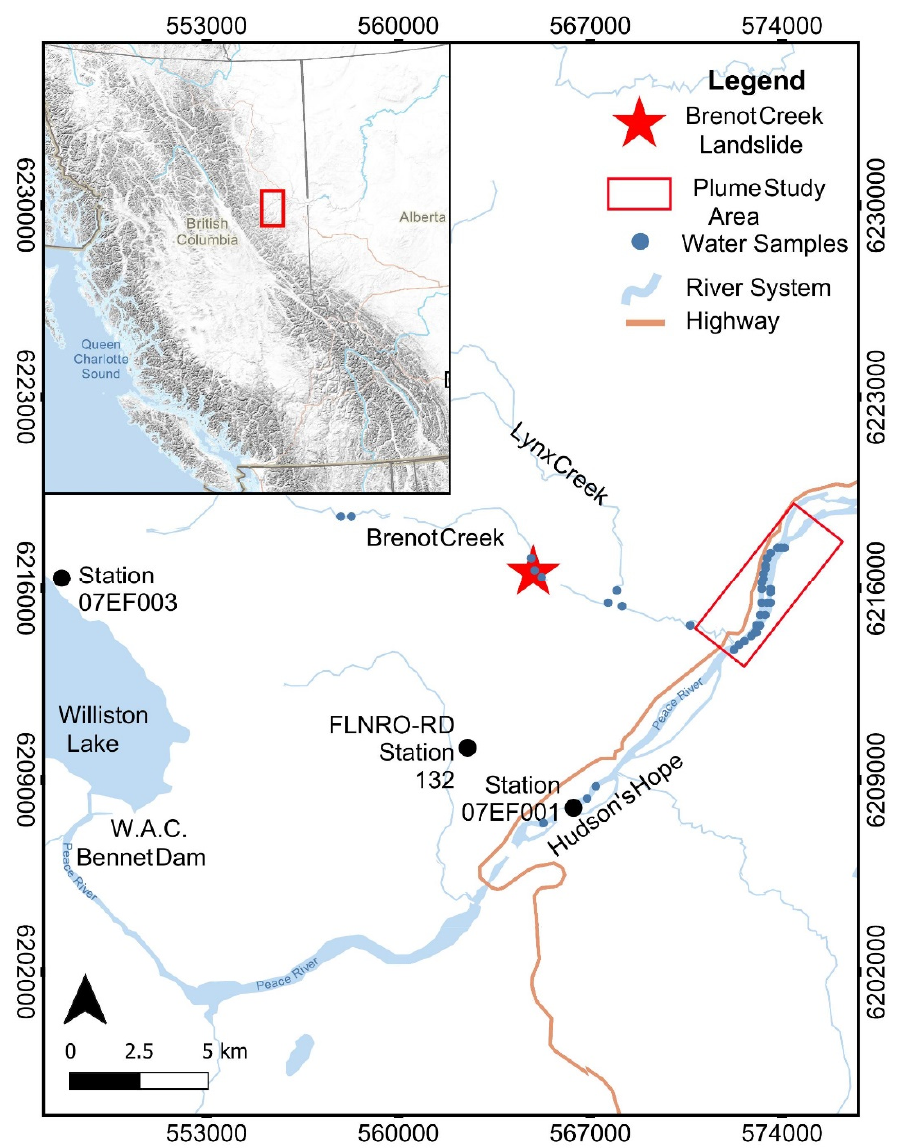
Figure 1. Map of the study area, near Hudson’s Hope, British Columbia, Canada. The Brenot Creek Landslide occurs along Brenot Creek, 12 km upstream of the Lynx Creek/Peace River confluence. Plume study area is indicated by a red rectangle downstream of Hudson’s Hope with the Peace River flowing to the northeast; also shown are meteorological monitoring stations used in this study and water sampling locations.